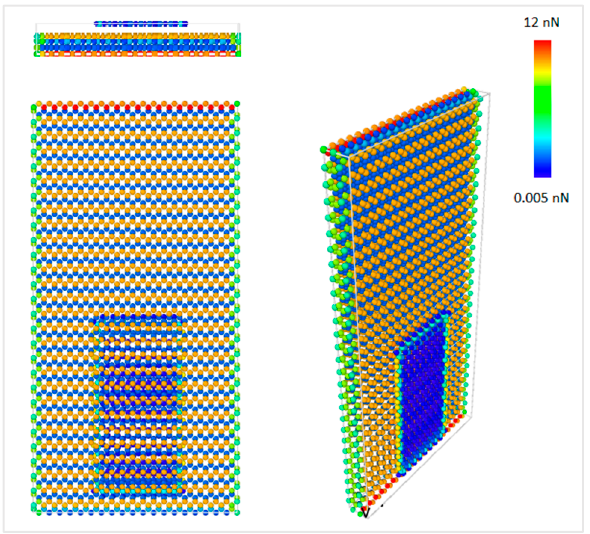
Figure 7. Atomic force contour of graphene during sliding with 0 degree chirality at 300 K.